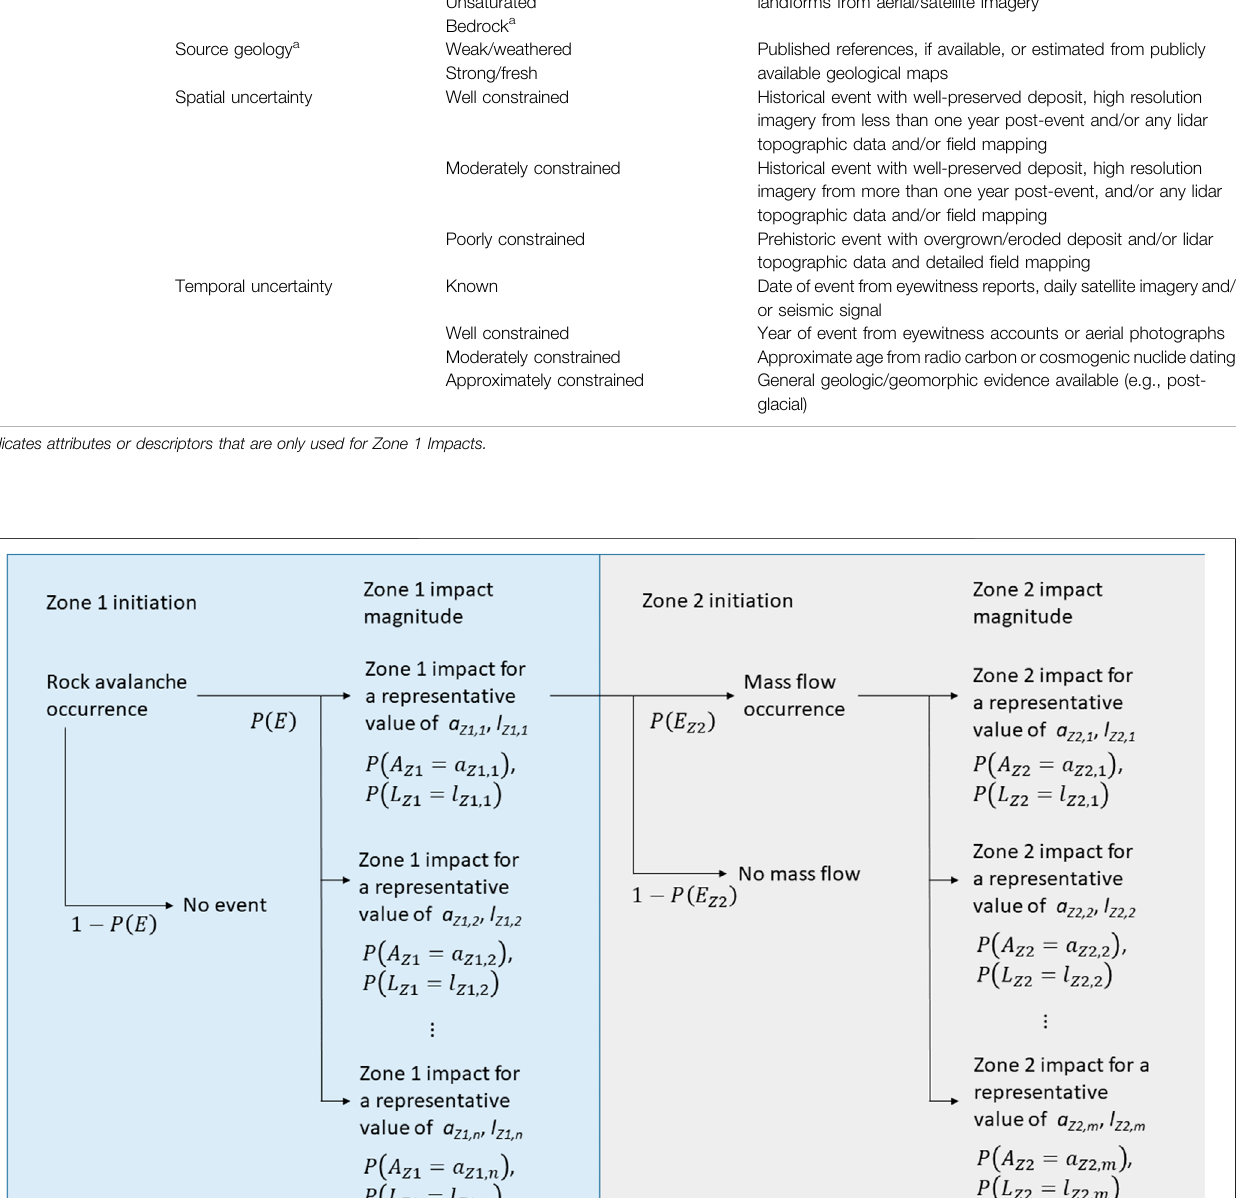
FIGURE7| EventtreefortheestimationofZone2impactareamagnitudes.Notethatonlythetopbranchoftheeventtreeisexpanded.Termsshownarede fi nedin the text.